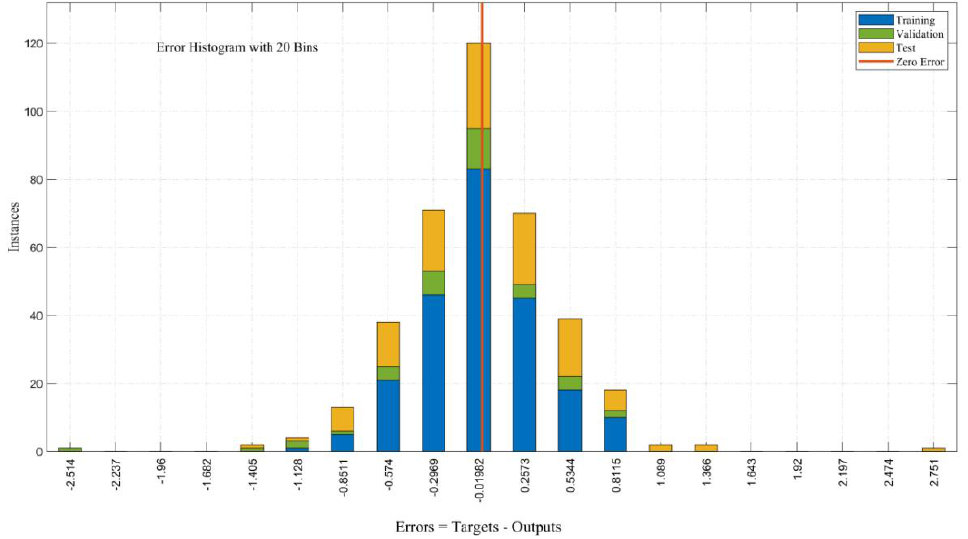
Figure 7. LM algorithm model error histogram.